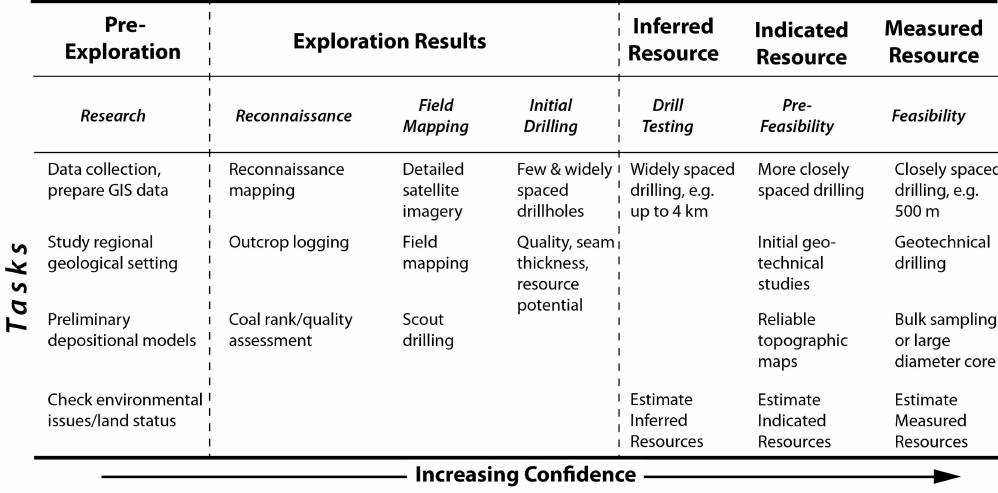
Figure 2. Typical stages in exploration programs; note that this example was developed for Indonesian programs with their emphasis on field mapping and channel sampling of coal outcrops in the early stages of exploration (modified from Friederich